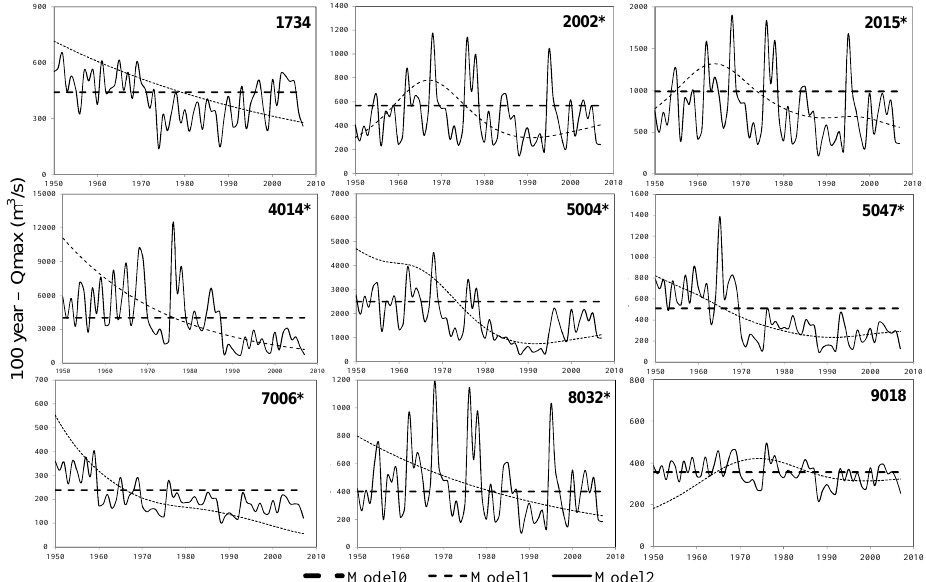
Figure 7. Quantile estimates of the annual maximum floods with 0.01 annual exceedance probability for the period 1950-2007, based on models 0, 1 and 2 (* means altered regime).